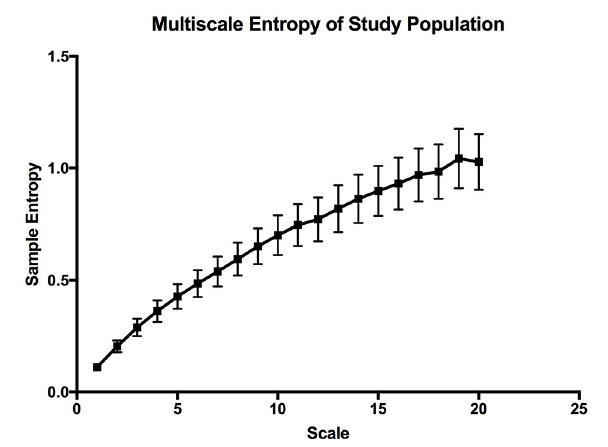
FIGURE 6 | Multiscale entropy graph describing the overall complexity of the whole study population. The error bars are calculated sample error of the mean